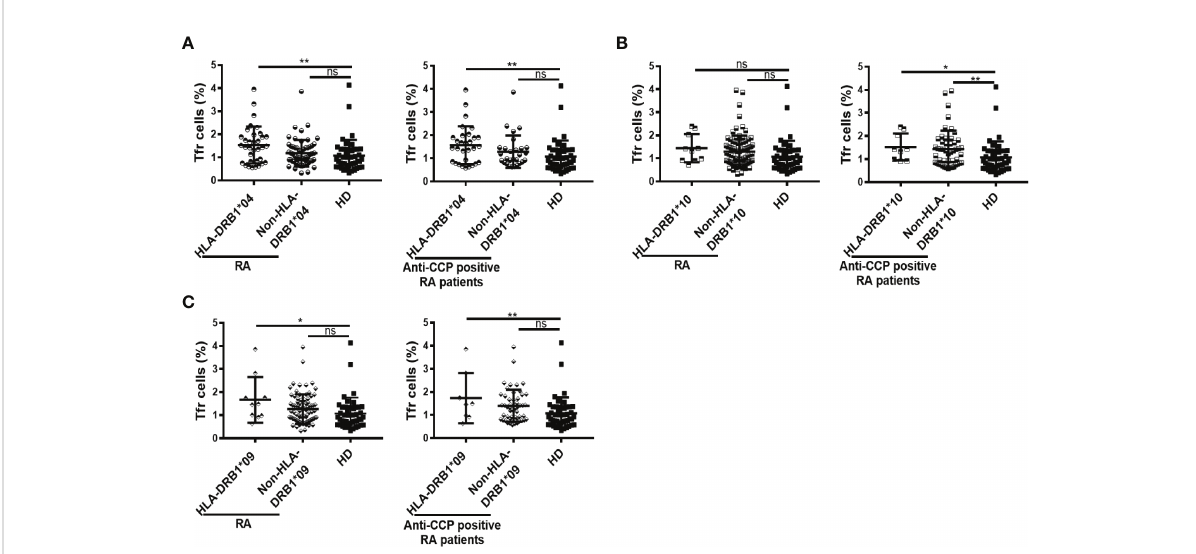
FIGURE 5 Frequency of Tfr cells according to HLA-DRB1 variants in RA patients. (A) Frequency of Tfr cells in RA patients (n=94) and in anti-CCP positive RA patients (n=58) divided by HLA-DRB1*04 presence (n=34 out of 94 RA patients and n=30 out of 58 patients with anti-CCP) and HD (n=43). (B) Frequency of Tfr cells in RA patients (n=94) and in anti-CCP positive RA patients (n=58) divided by HLA-DRB1*10 presence (n=10 out of 94 RA patients and n=9 out of 58 patients with anti-CCP) and HD (n=43). (C) Frequency of Tfr cells in RA patients (n=94) and in anti-CCP positive RA patients (n=58) divided by HLA-DRB1*09 presence (n=10 out of 94 RA patients and n=8 out of 58 patients with anti-CCP) and HD (n=43). Symbols represent individual subjects. Mean ± DS is shown. P values were determined by One-way Analysis of Variance (ANOVA) followed by Bonferroni Multiple Comparisons Test in (A) , (B) all RA patients and (C) . Kruskal-Wallis Test followed by Dunn ’ s Multiple Comparisons Test were used in (B) anti-CCP positive RA patients. Two-tailed probability * p < 0.05, ** p < 0.01, ns, not signi fi